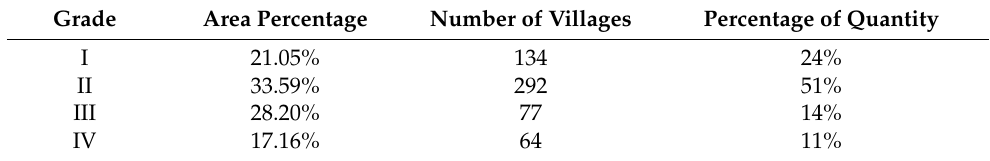
Figure 7. Classification of the suitability evaluation of ethnic minority villages in Fujian Province. Table 5. Statistical results of suitability classification of the ethnic minority village in Fujian